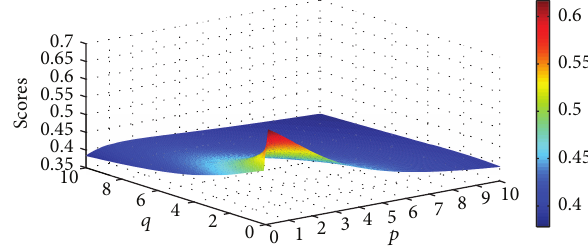
Figure 5: Scores for District 𝐴 1 obtained by the IIFGWHM operator ( 𝑝 ∈ (0,6],𝑞 ∈ (0, 6] ).